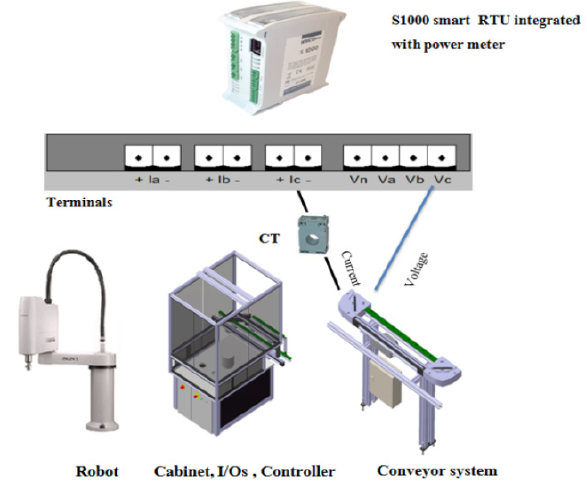
Figure 5. Power consumption monitoring in the testbench [2].